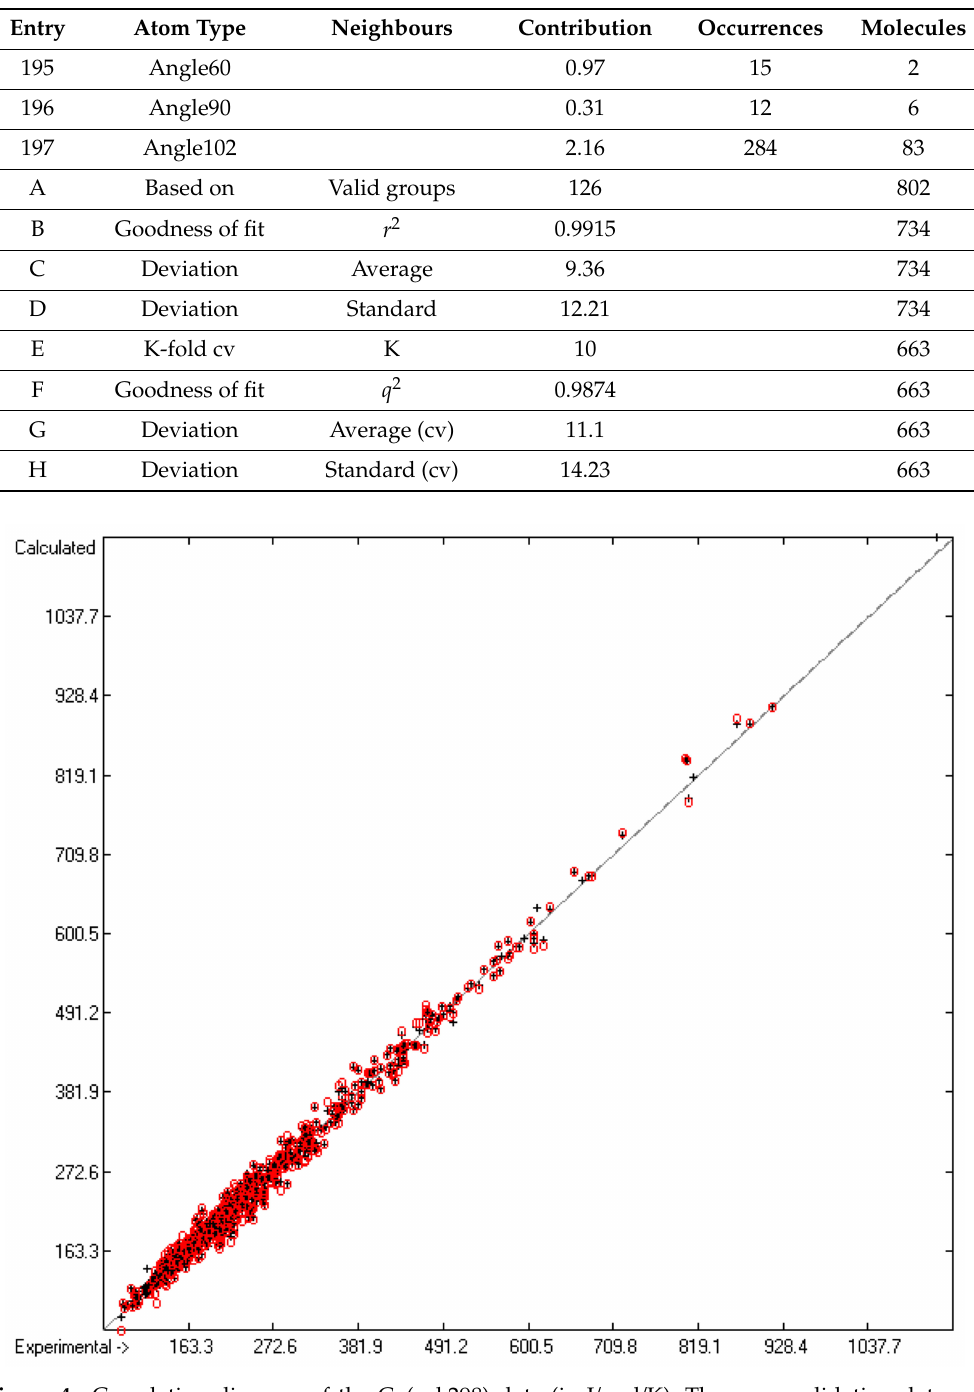
Figure 4. Correlation diagram of the C p (sol,298) data (in J / mol / K). The cross-validation data are superimposed as red circles. ( n = 734; r 2 = 0.9915; q 2 = 0.9874; regression line: intercept = − 0.0999; slope =